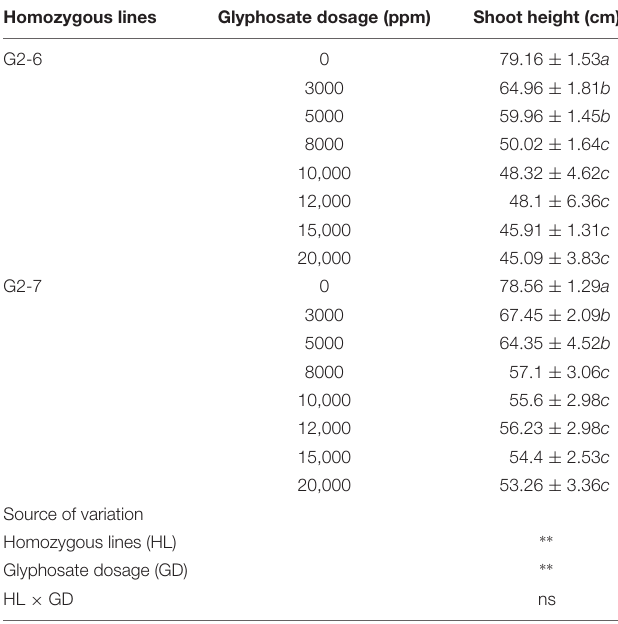
TABLE 1 | Agronomic performances of selected transgenic lines under different glyphosate treatments. Homozygous lines Glyphosate dosage (ppm) Shoot height (cm)